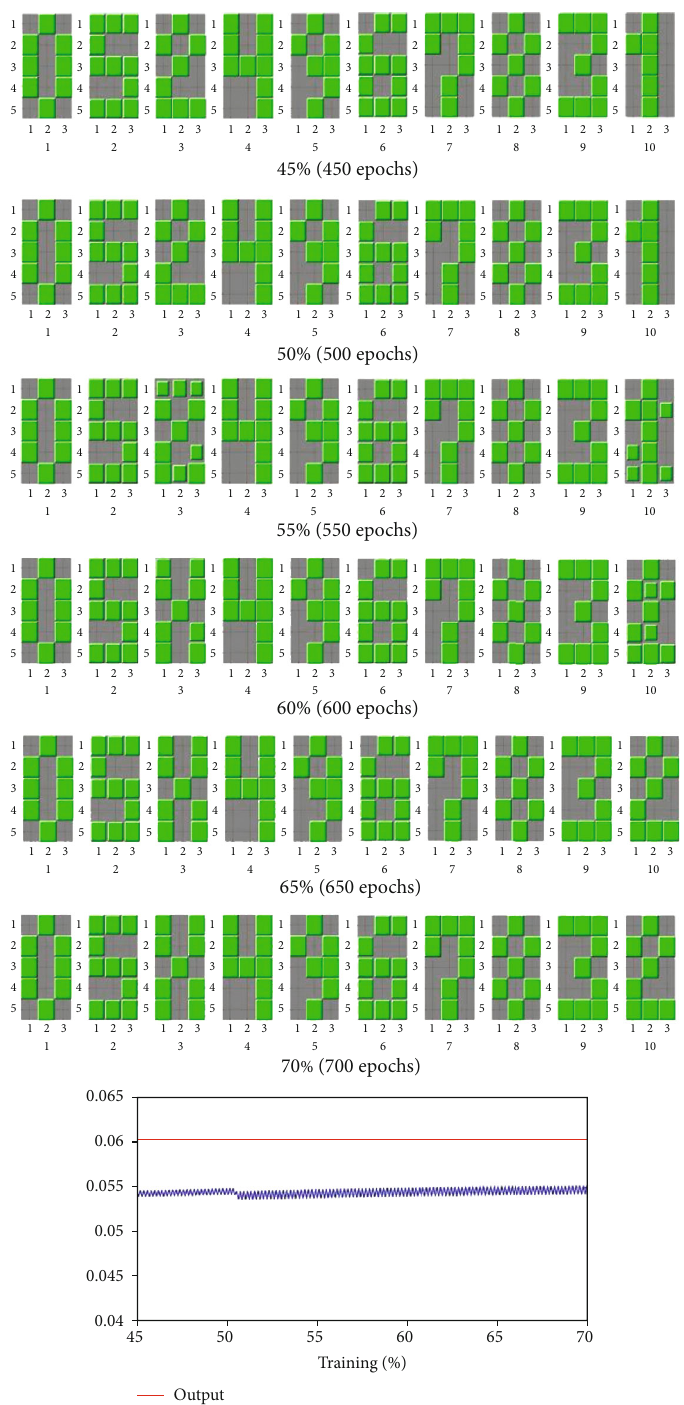
Figure 5: Example of koniocortex continuous learning under physiological (not defective) conditions. Each of the six rows represents the learning status at a selected epoch (iteration), being 1,000 the total number of epochs. In each of the six rows, ten synaptic weight matrices are corresponding to each one of the ten spiny neurons in the simulation, being each spiny neuron identi fi ed by a number below each matrix. The relative size of the fi fteen green tiles in each matrix corresponds to the relative value of the weights of the recurrent virtual connections from spiny to input neurons. When, at epoch 500, one of the training patterns, pattern one, was substituted by a new pattern, pattern X, there is a process of weight reorganization for deciding which spiny neuron will fi re in front of pattern X. At the end (see rows corresponding to epochs 650 and 700), spiny neuron three fi res in front of pattern X and spiny neuron ten fi res when pattern two is presented to the koniocortex model. In the bottom graph, we depict two curves: the red curve is the average output and the blue curve the average shift along with iterations. Both curves exhibit stable and regular